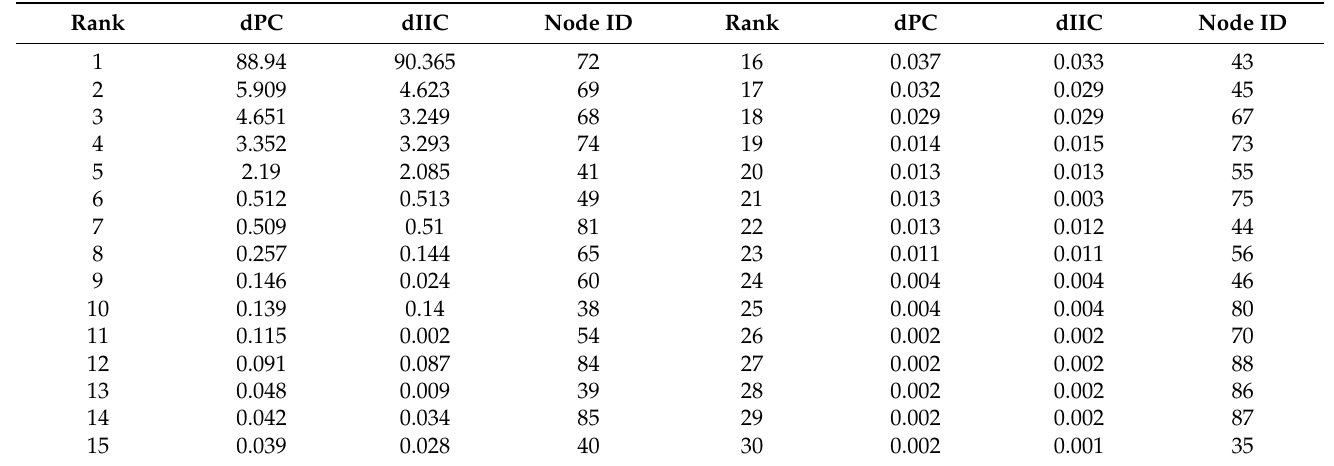
Table 3. The top 30 connectivity values in the core patches.